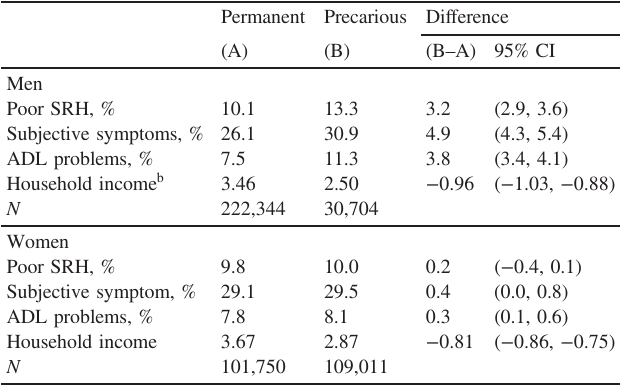
Table 2. Health outcomes and household income by employ- ment status a